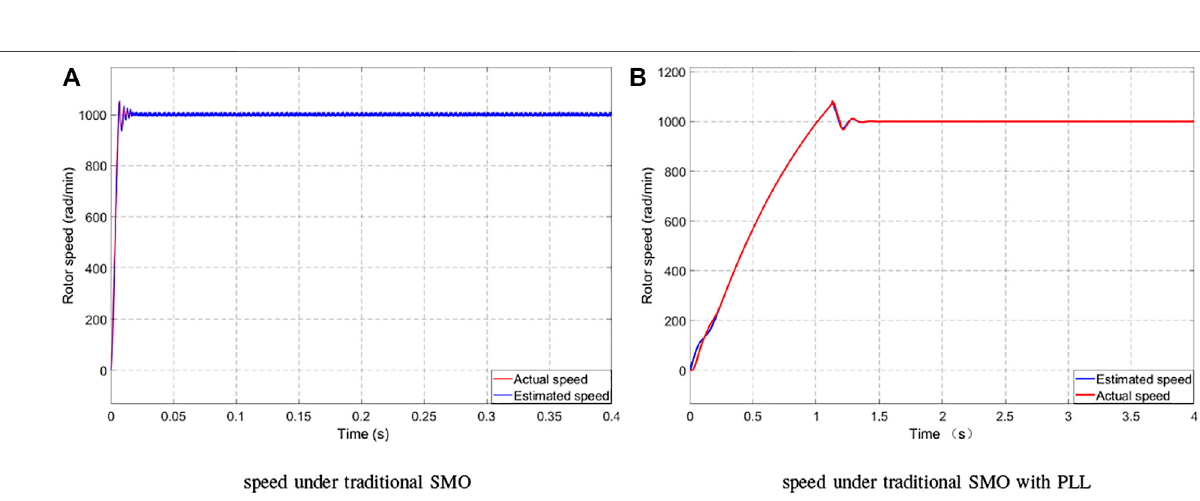
FIGURE 6 | System structure block diagram of PMSM sensorless control based on SMO with PLL.